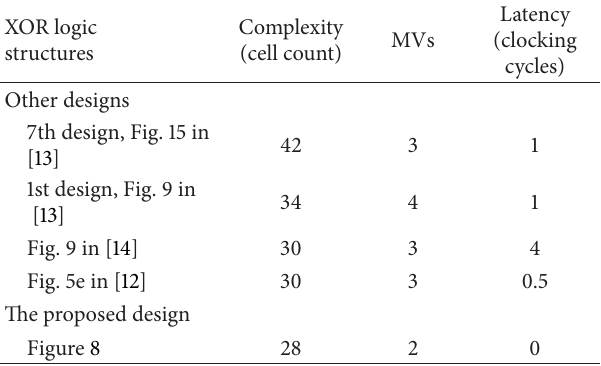
Table 2: Comparison between the proposed QCA design for the XOR gate and other